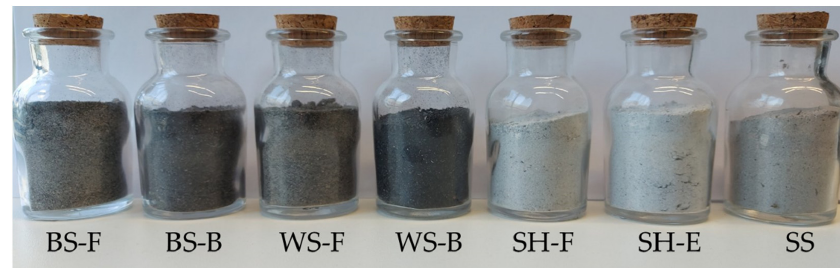
Figure 1. Different types of ABA. Table 2. Chemical composition of industry-generated ABAs .